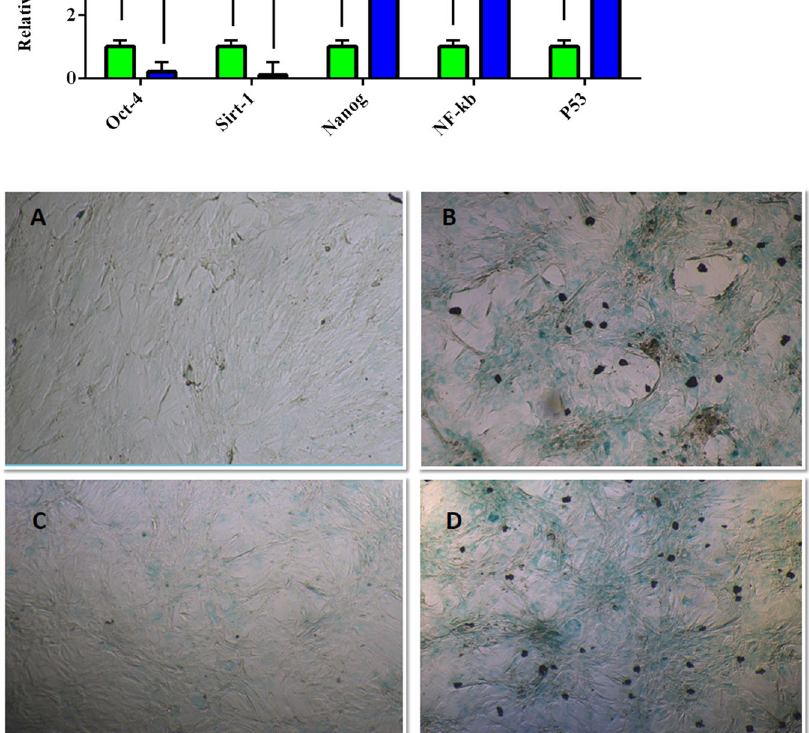
Fig. 9 Senescence-associated- β -galactosidase (SA- β -gal) staining in the rATSCs and rBMSCs at 100 and 200 µg/ml TiO 2 NPs. SA- β -gal-positive cells could be observed more frequently in the B rATSCs and D rBMSCs treated with 100 and 200 µg/ml TiO 2 NPs, respectively compared to control groups ( A and C